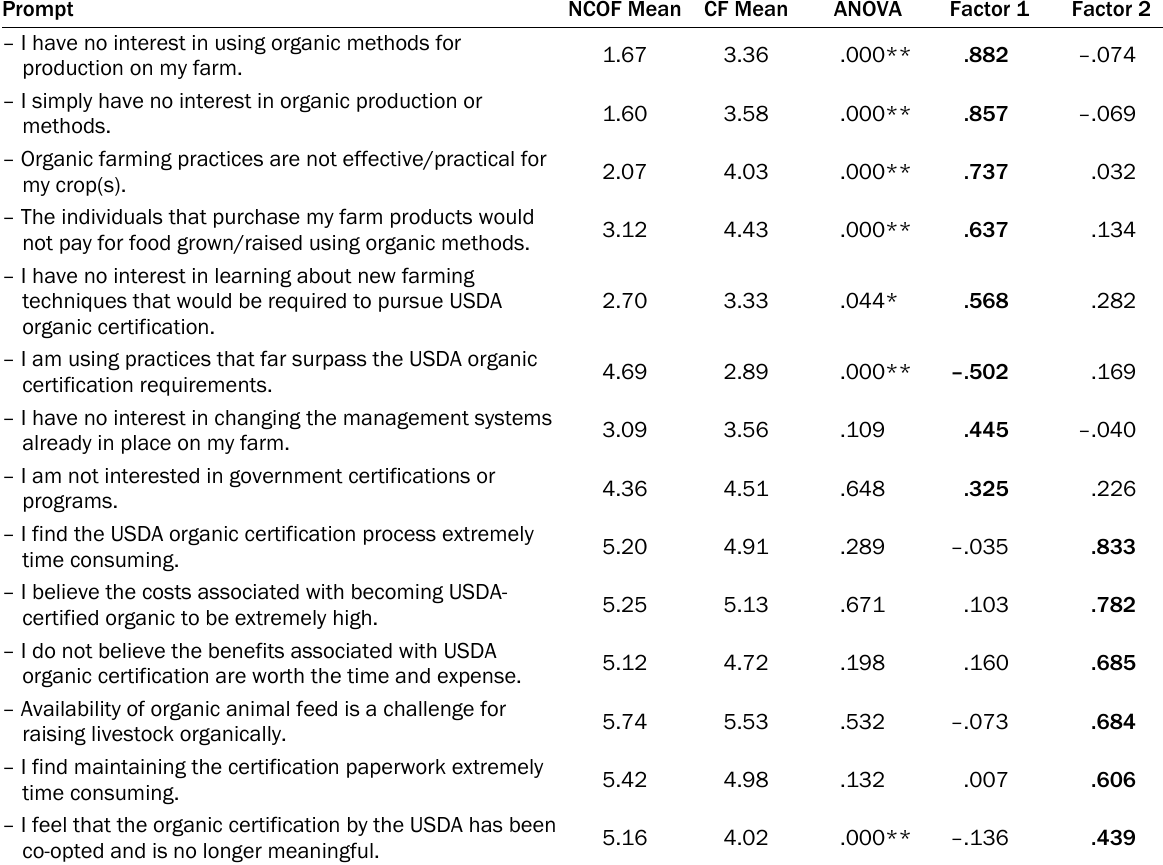
Table 4. ANOVA and PCA Results from Likert Scale Assessing Interest in Pursuing Organic Certification and